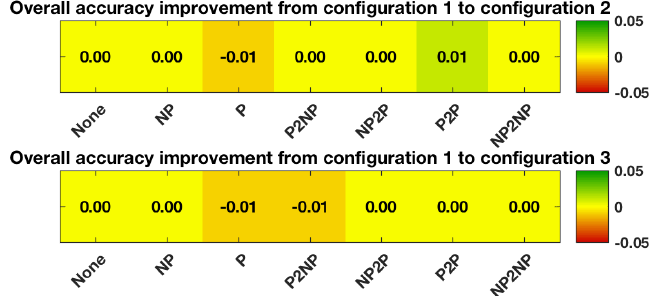
Figure 7. Overall accuracy improvements from Configuration 1 to Configuration 2 (top) and from Configuration 1 to Configuration 3 (bottom). Only the improvements with a significance level of 0.05 are